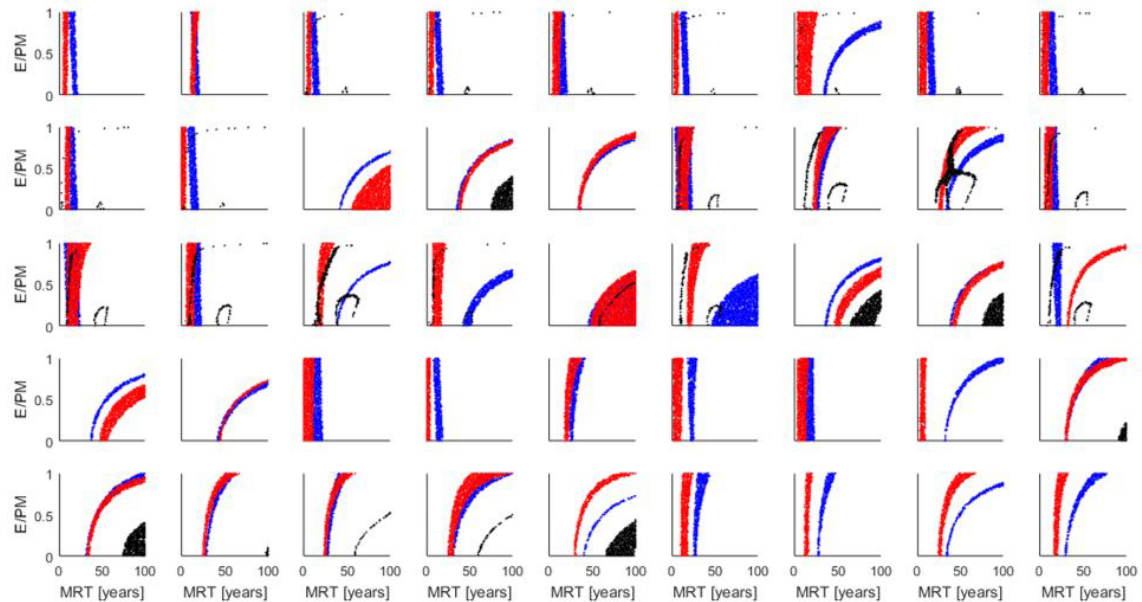
Figure A6. Behavioural age information (MRT and E / PM) inferred from SF 6 (red), tritium (black) and Halon-1301 (blue) for sites 228 to